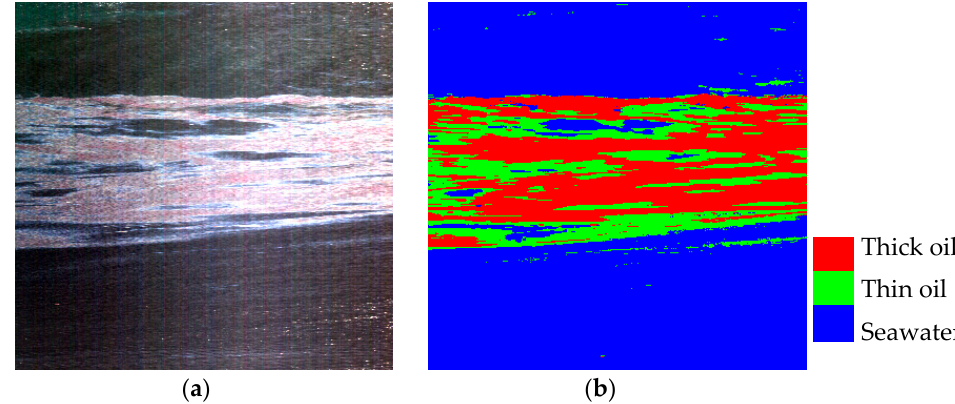
Figure 2. Oil spill dataset 1. ( a ) False-color image and ( b ) ground-truth image.